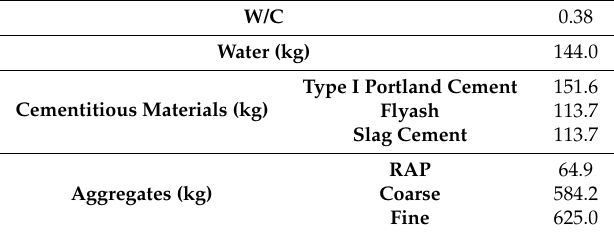
Table 1. Mix design proportions. W: Water ; C: